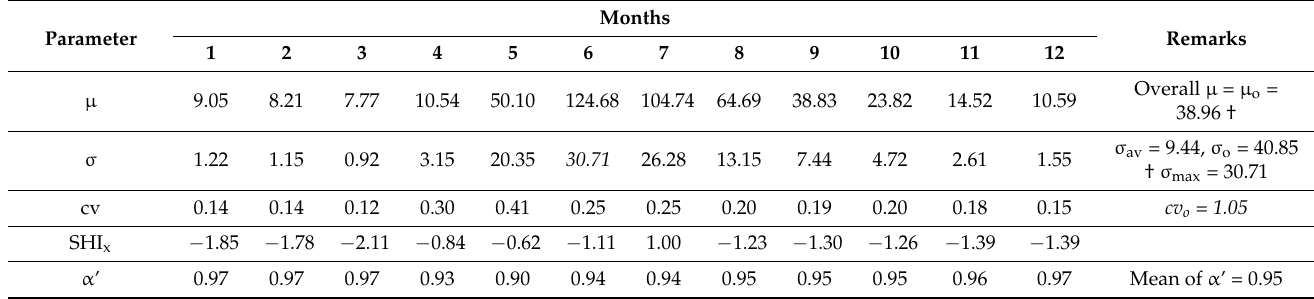
Table 1. Summary of statistical parameters of annual and monthly flow sequences of the Bow